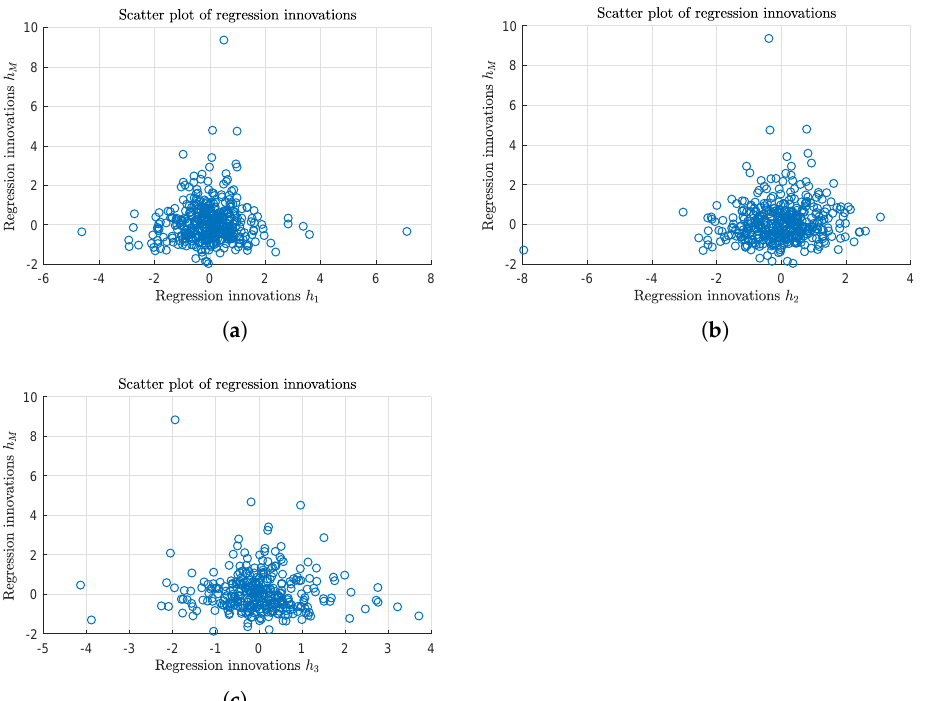
Figure 19. Scatter plot of the bivariate vector [ h 1 , h m ] in panel ( a ), [ h 2 , h m ] , panel ( b ), and [ h 3 , h m ] , panel ( c